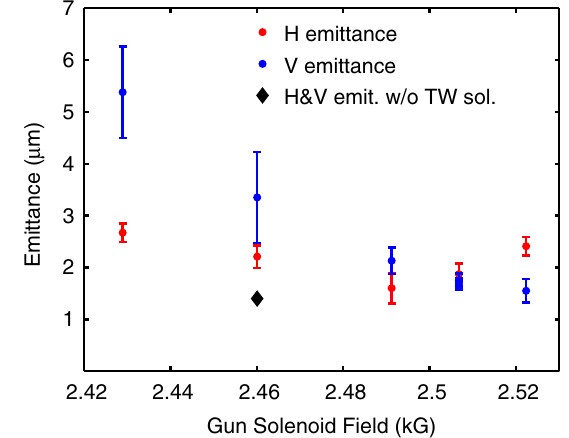
FIG. 12. Gun solenoid scan of projected emittance with TW solenoids switched on and no rf compression. The black dia- mond represents the best horizontal and vertical emittance found with TW solenoids